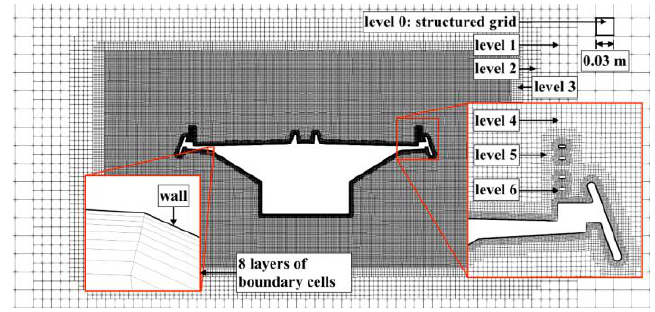
Figure 14. Details of mesh No.5.